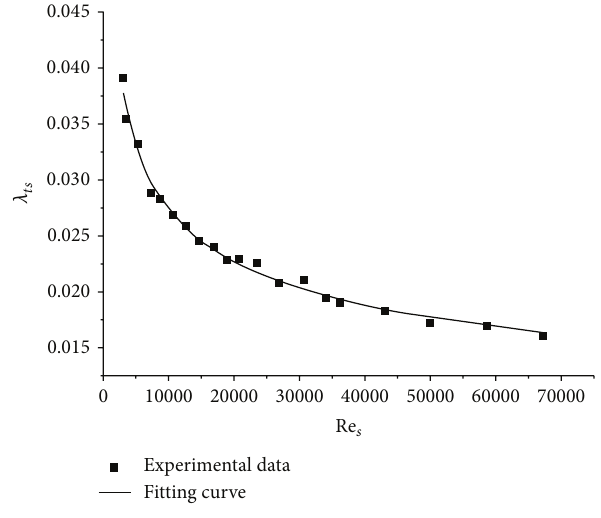
Figure 3: Fitting curve of Re 𝑠 and 𝜆 𝑡𝑠 .